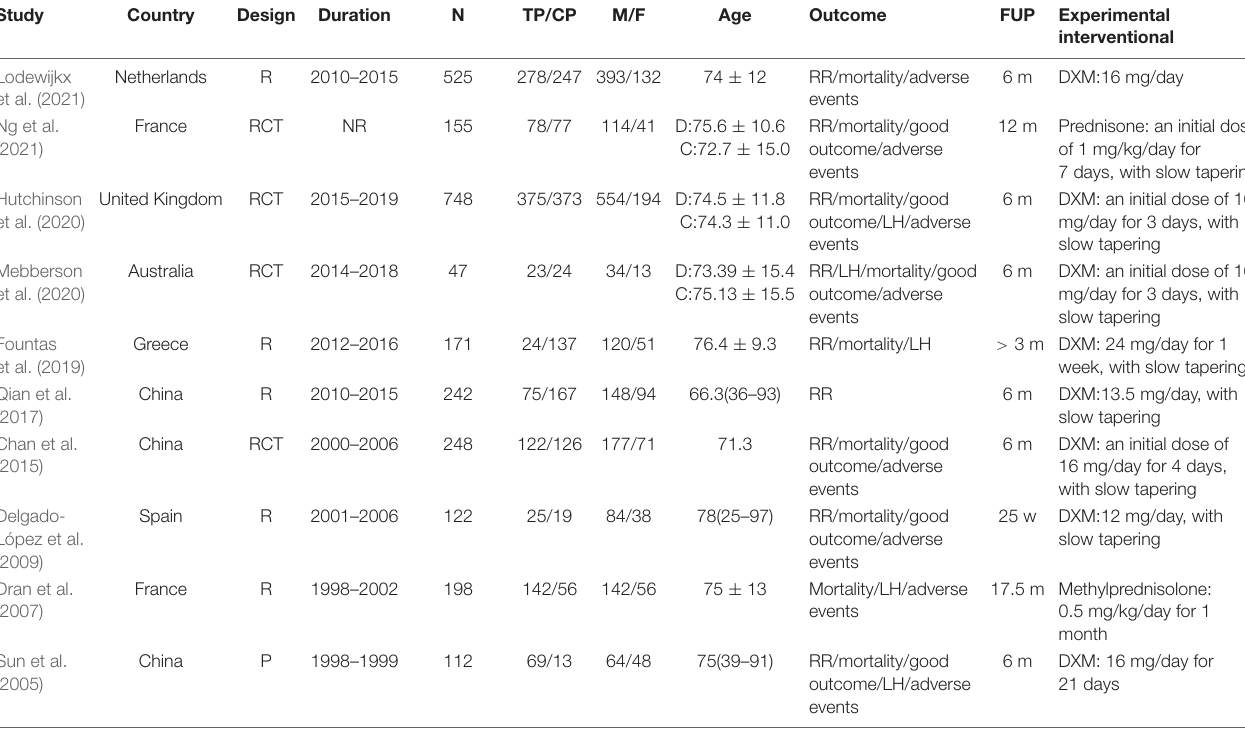
TABLE 2 | Baseline characteristic of included studies.